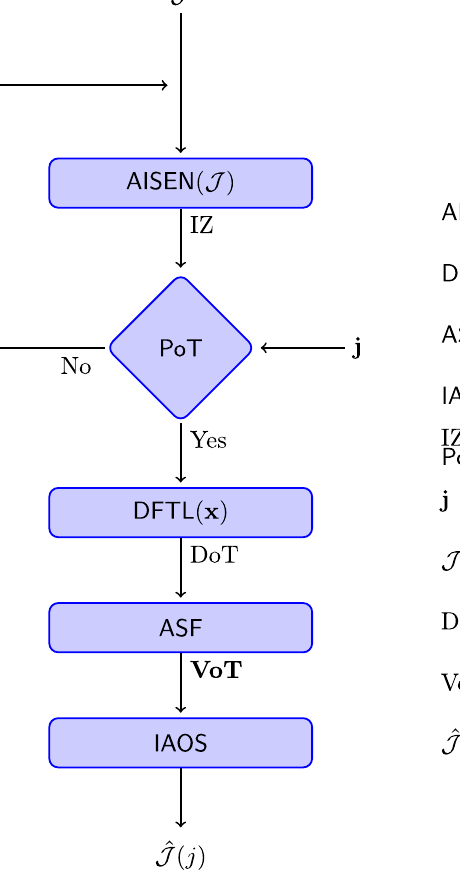
Fig. 4 Scheduling